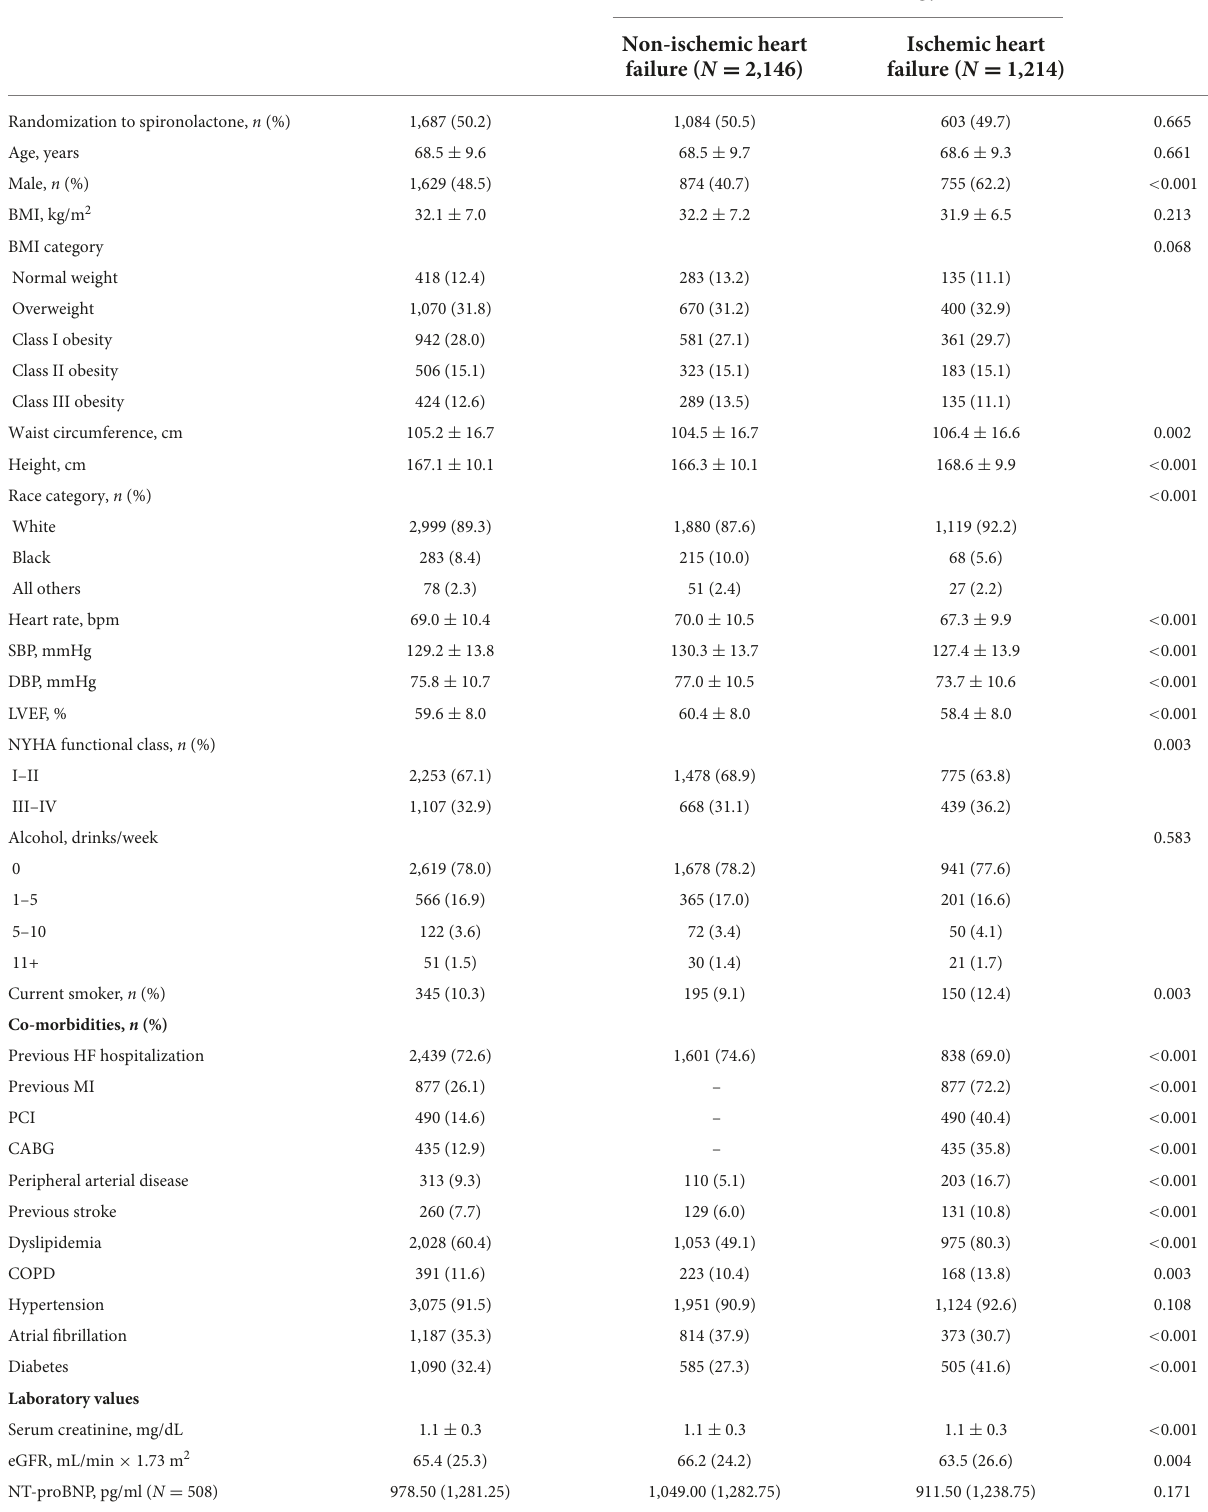
TABLE 1 Patient characteristics according to heart failure etiology.